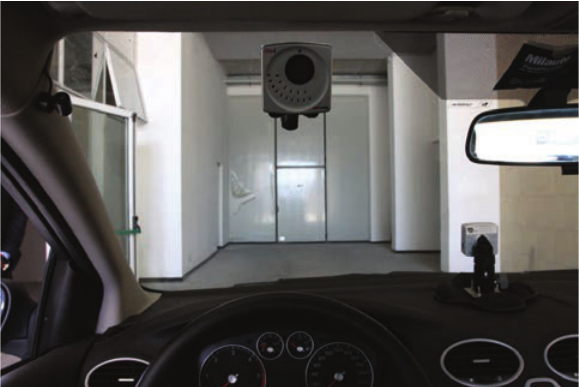
Fig. 1. Cockpit of the instrumented